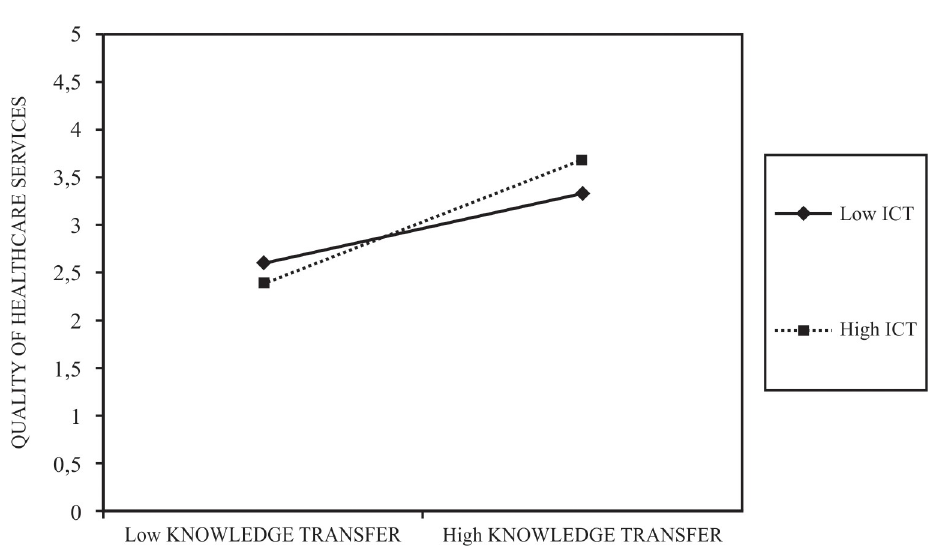
Fig 3. Interaction between knowledge sharing and information communication technologies in influencing quality of healthcare services.